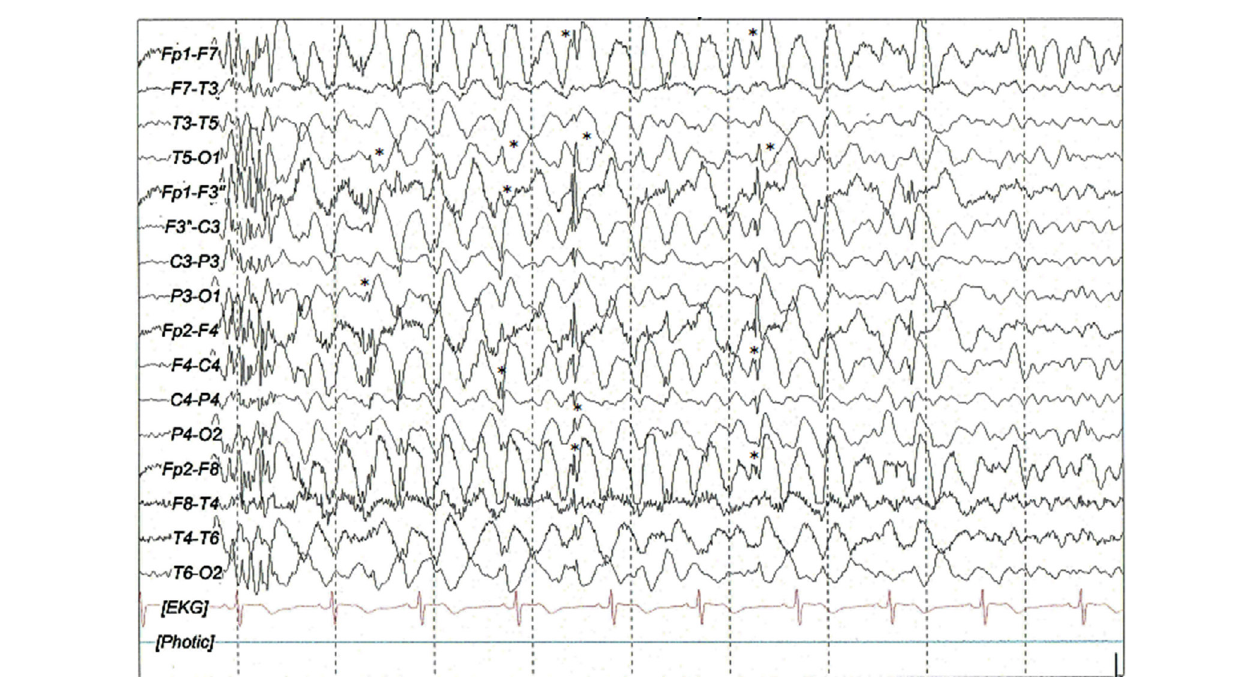
FIGURe 1 | Interictal sleep (N1 stage) eeG scalp recording with generalized paroxysm of poly-spikes followed by fragmented 1–1.5 Hz spike and slow-wave complexes (*) mixed with slow waves at 3–4 Hz with higher amplitude in the anterior quadrants . Filters: 0.03–70 Hz, notch: 60 Hz, sensitivity: 7 μ V/mm.